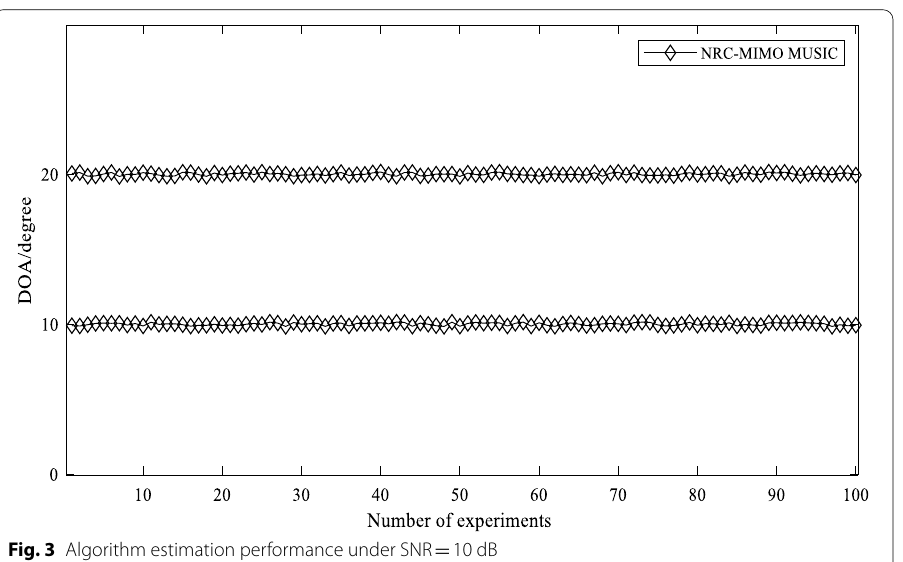
Fig. 3 Algorithm estimation performance under SNR